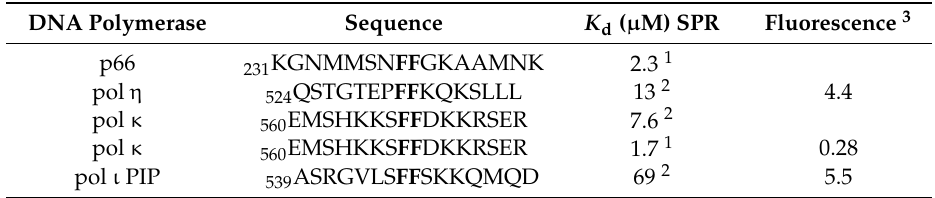
Table 2. Apparent dissociation constants ( K d ) of human p66 (a subunit of pol δ ), pol η , pol κ , and pol ι RIR peptides with human Rev1. Conserved phenylalanine residues are in